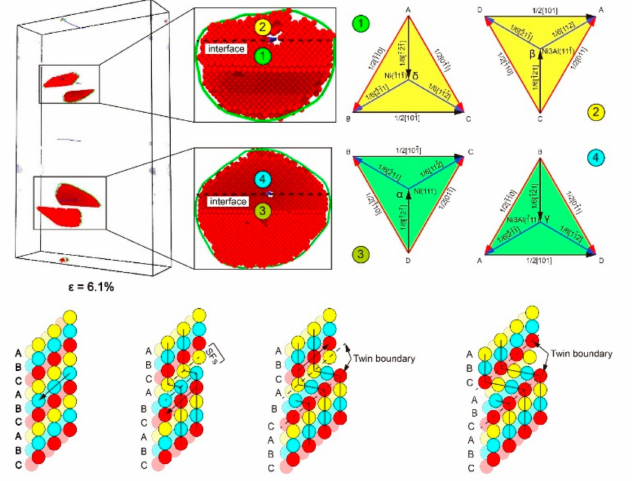
Figure 14. The slip system in dislocation and the forming process of the stacking fault and twin boundary in the model with α = 90 ◦